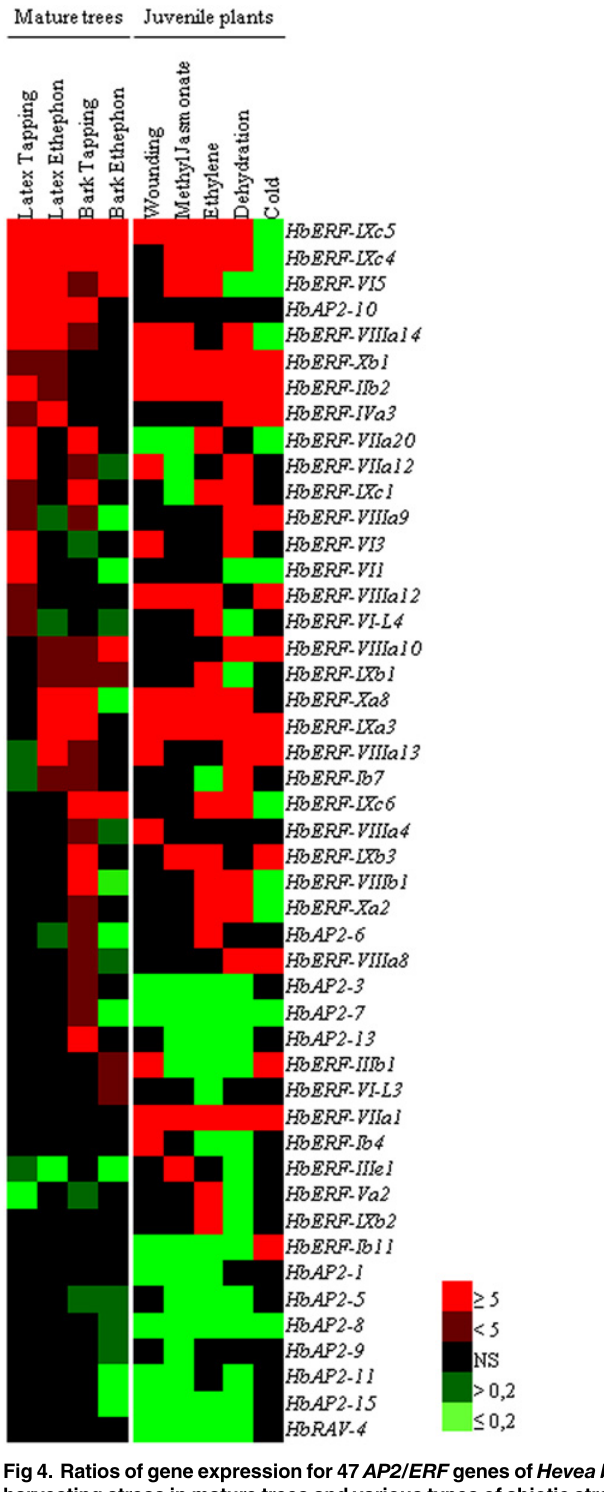
Fig 4. Ratios of gene expression for 47 AP2/ERF genes of Hevea brasiliensis in response to latex harvesting stress in mature trees and various types of abiotic stress in juvenile plants. Up-regulated genes are shown in bright red for a threshold value (cid:1) 5, dark red for a value 2 < n < 5, and down-regulated genes are shown in bright green for a threshold value (cid:3) 0.2, dark green for a value 0.5 > n > 0.2. The non- significant fold changes are shown in a dark